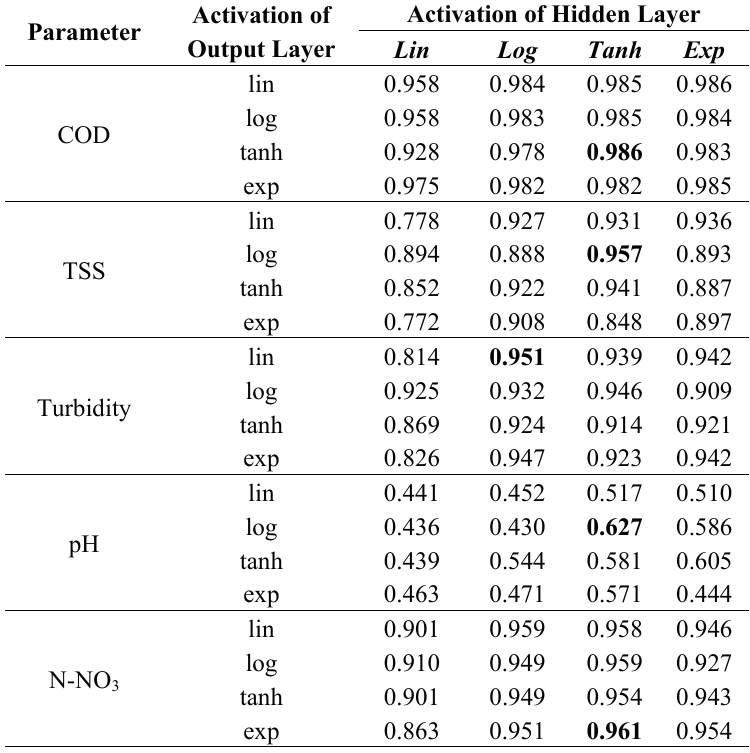
Table 5. Mean values of neural network validation quality with 20 hidden neurons, considering different combinations of activation functions for each of wastewater quality parameters. The highest values for each parameter of treated wastewater quality are indicated in bold